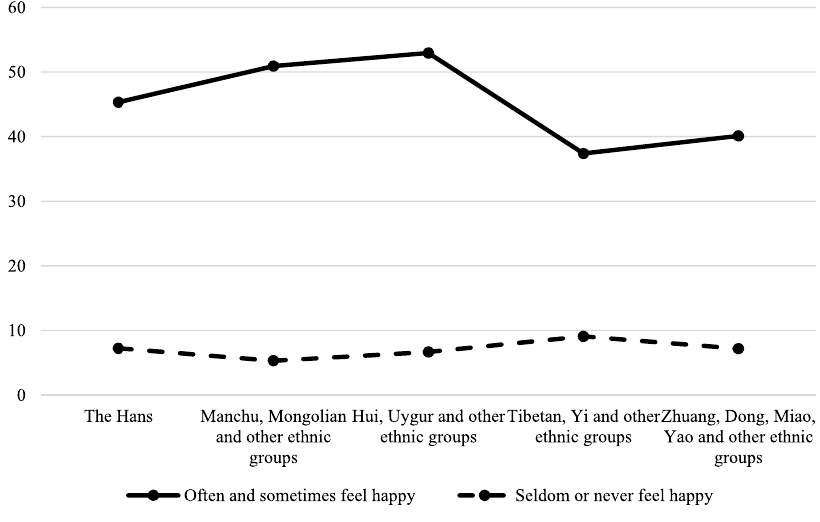
Fig. 2 Line graph showing the ethnic groups who indicated that they often feel happy or unhappy in the western regions of